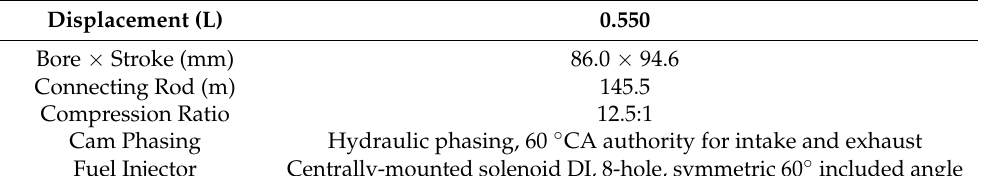
Table 1. Engine geometry.